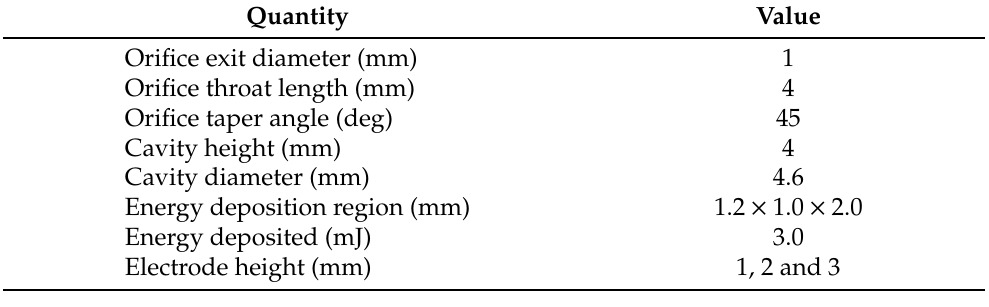
Figure 20. SparkJet model. Adapted from [56]. Table 4. SparkJet Model Characteristics. Table 4. SparkJet Model Characteristics